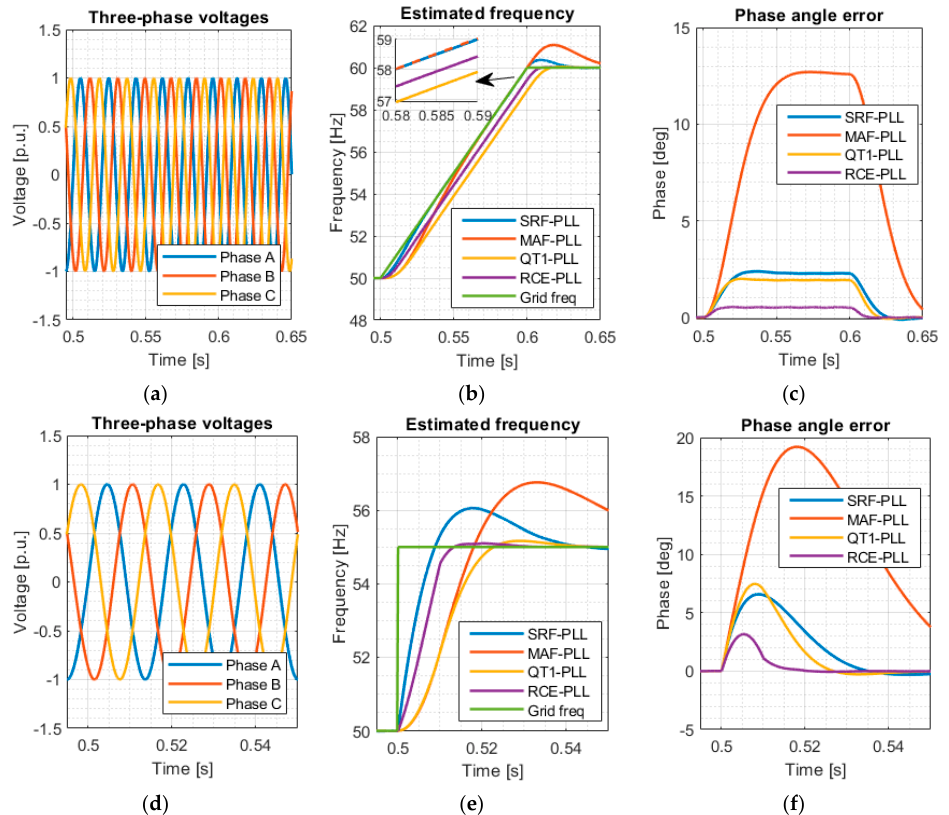
Figure 14. Grid frequency change test ( a – c ): +100 Hz/s ramp change; ( d – f ): Frequency step change to 55 Hz. ( a ) Grid voltage waveforms; ( b ) estimated grid frequency; ( c ) phase angle error; ( d ) grid voltage waveforms; ( e ) estimated grid frequency; ( f ) phase angle error.